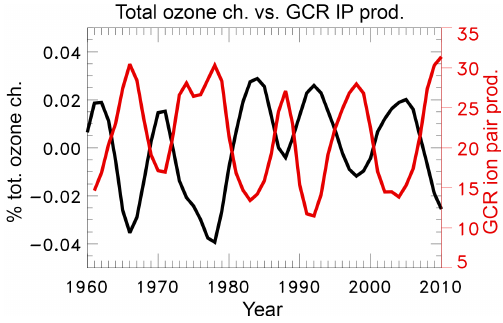
Figure 13. GSFC 2-D model GCR-computed AAGTO change (black line) over the 1960–2010 time period caused by the inter- annual GCR variation. The global total ozone change shown in Fig. 11c is differenced from that shown in Fig. 11a. A 2-year boxcar (running) average of the GCR ion pair production (in cm − 3 s − 1 ) at 200hPa and 90 ◦ S with a 1-year lag is also shown (red